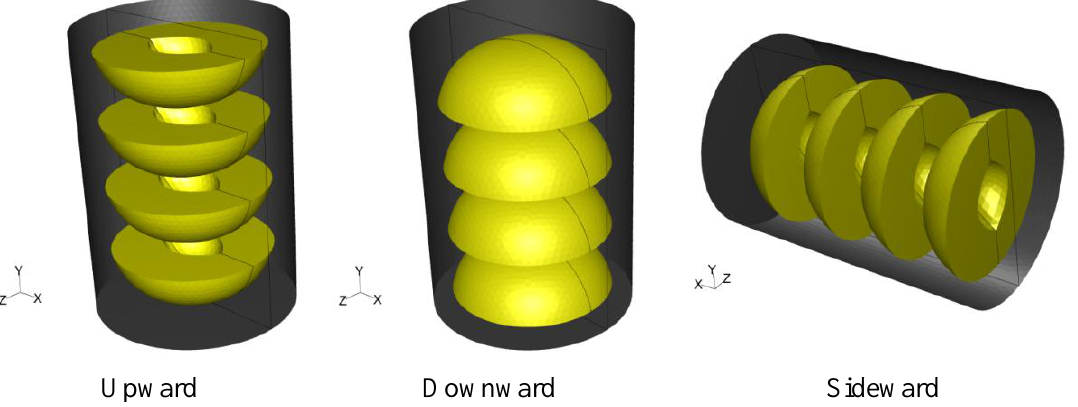
Upward Downward